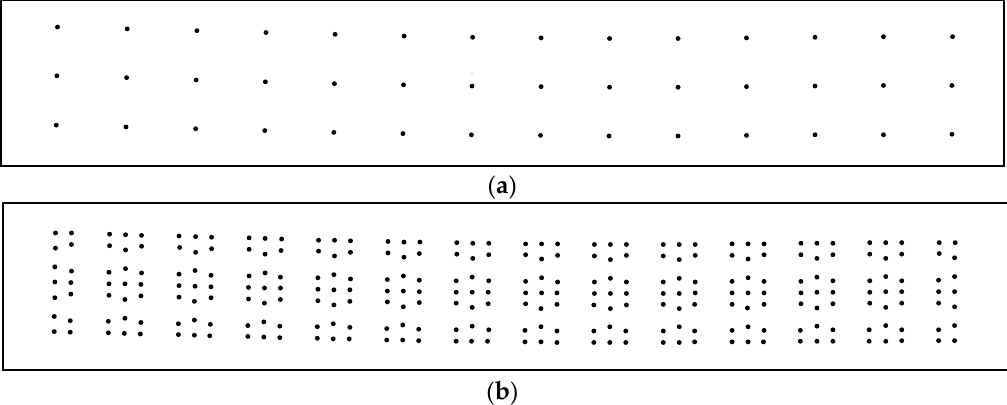
Figure 15. Arrangements of original points for DIP-based displacement tracking: ( a ) TP (42 points), and ( b ) expanded TP (280 points).